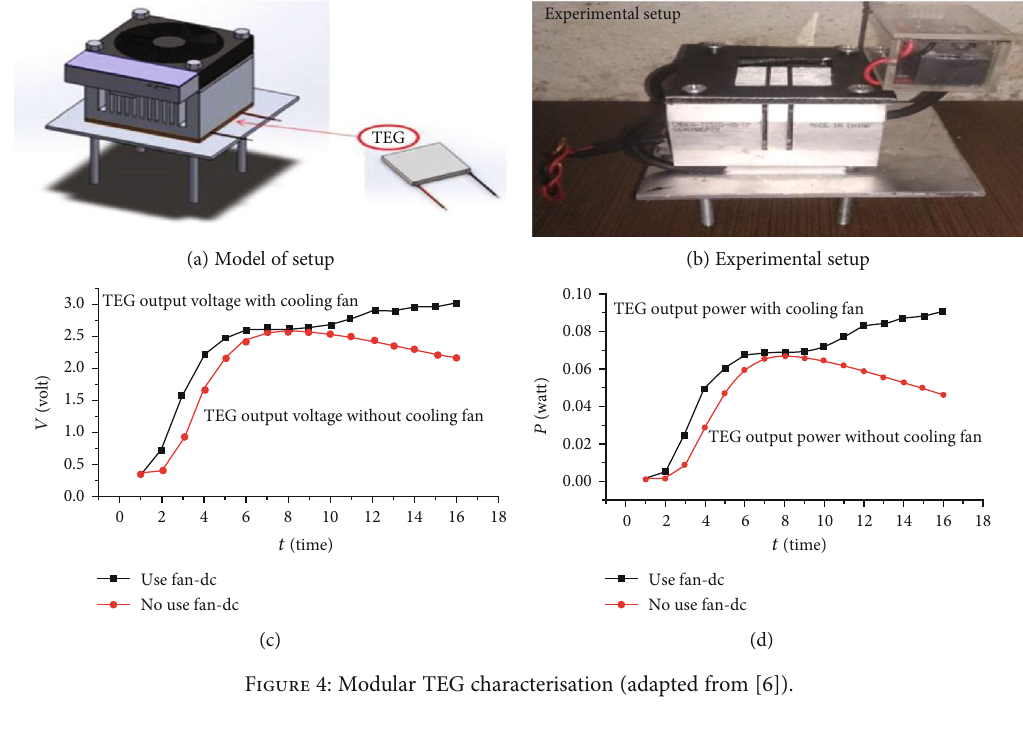
Figure 4: Modular TEG characterisation (adapted from